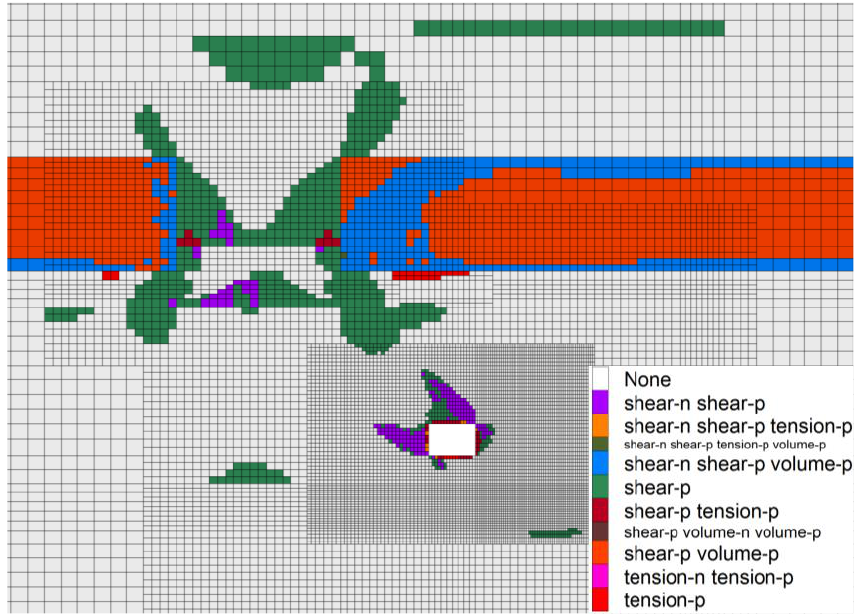
Figure 26. Plastic zone distribution cloud map when the coal column is 25 m. (5) Roadway dug directly below the residual coal pillar When the roadway is located directly below the residual coal pillar, the vertical dis- tance from the residual coal pillar of the overlying coal seam is about 18.5 m. According to the stress cloud diagram (Figure 27), σ 1 and σ 3 appear at the residual coal pillar of the overlying coal seam, and σ 1 near the overlying residual coal pillar is about 61 – 104 MPa, and σ 3 is about 22 – 50 MPa. σ 1 around the roadway is about 5 – 24 MPa, and σ 3 is about 0.4 – 7 MPa.